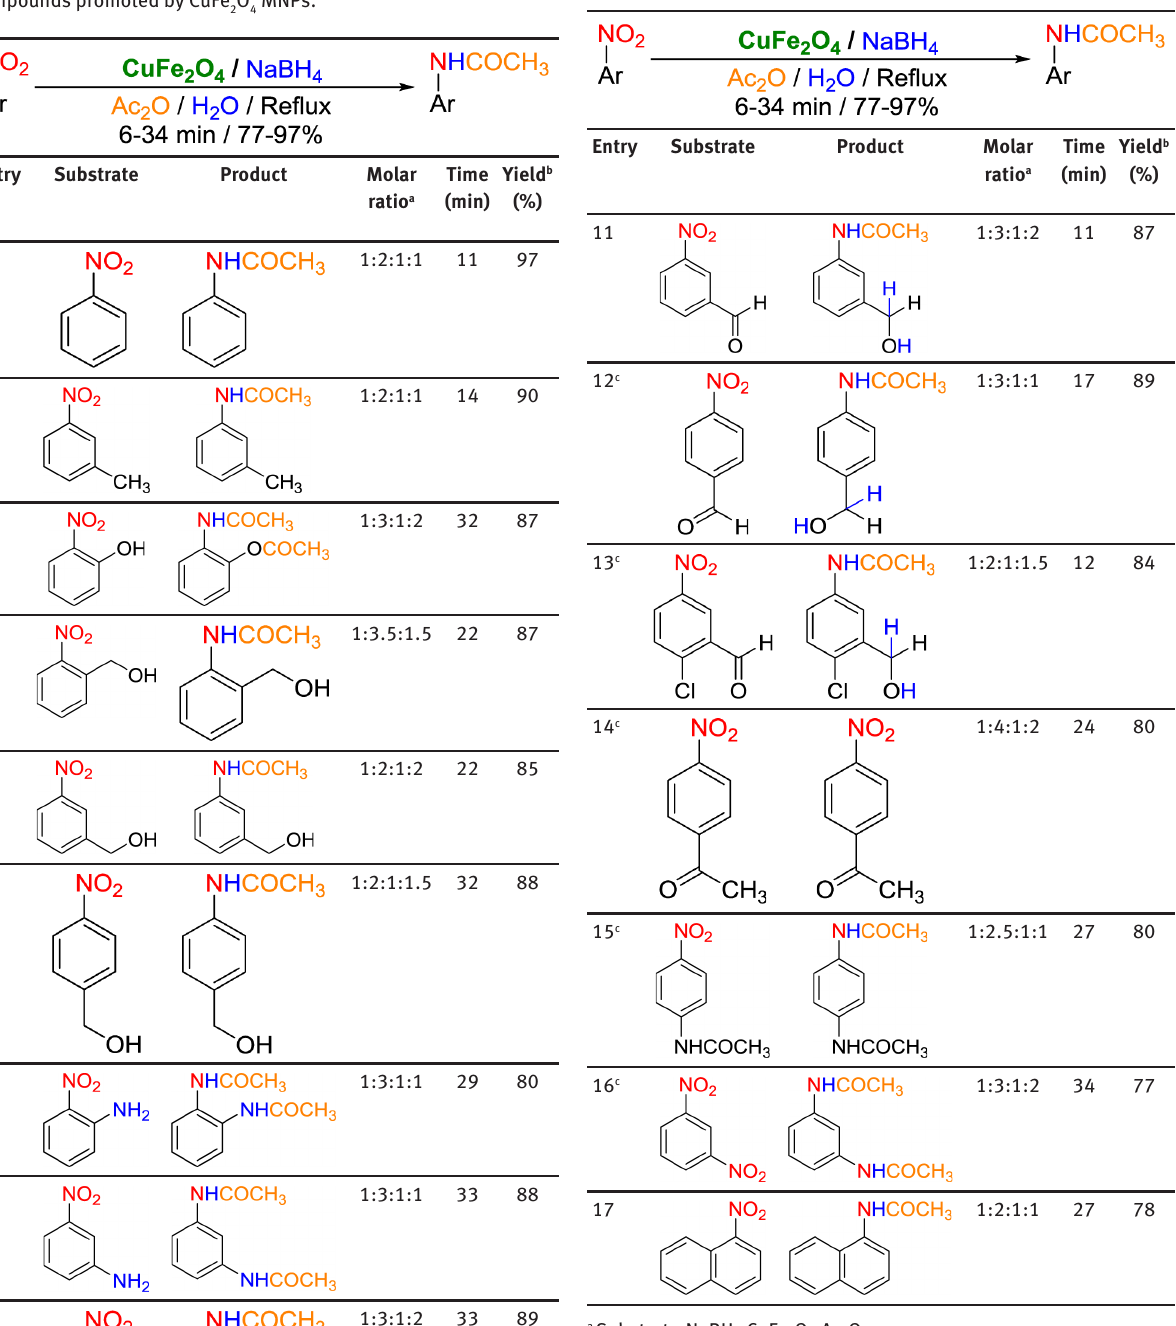
Table 4: One-pot reductive acetylation of aromatic nitro compounds promoted by CuFe